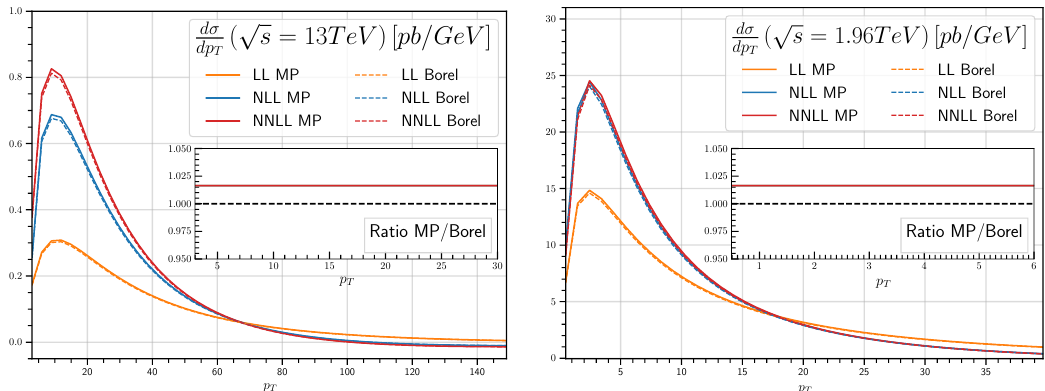
Figure 4. Comparison of the Minimal and Borel prescription for the transverse momentum dis- tribution of the Higgs ( left ) and Z boson ( right ). The renormalization ( µ R ) and factorization ( µ F ) scales are set equal to the Higgs mass ( m H ) and the Z boson mass ( m Z ) in the case of Higgs and DY production respectively. The normalizations are fixed to the total cross